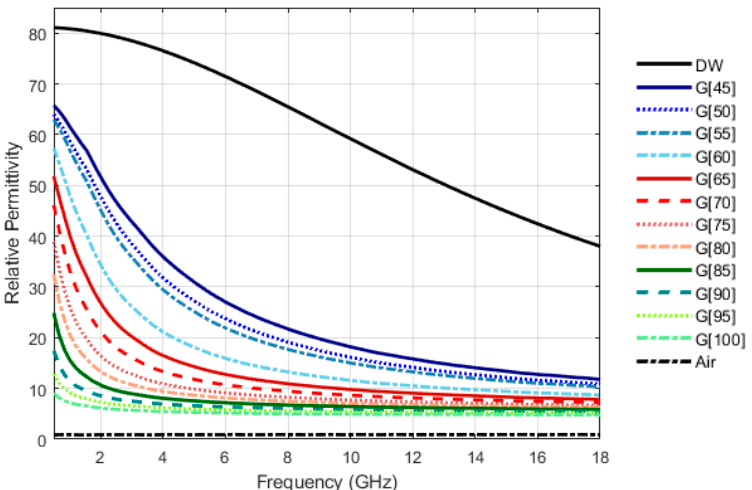
Figure 3. Relative permittivity of produced coupling media at [18.4 ± 0.4] °C. Glycerin volume percentage in the mixtures is given by X in G[X]. Distilled water (DW) and air relative permittivity are presented as a reference.